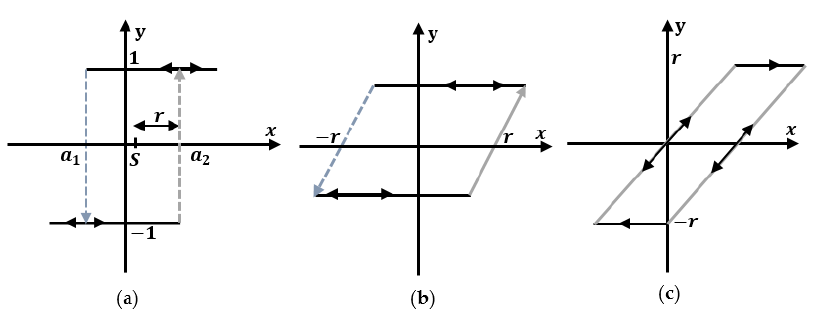
Figure 5. State transitions of Preisach operators: ( a ) relay operator; ( b ) play operator; and ( c ) stop operator.